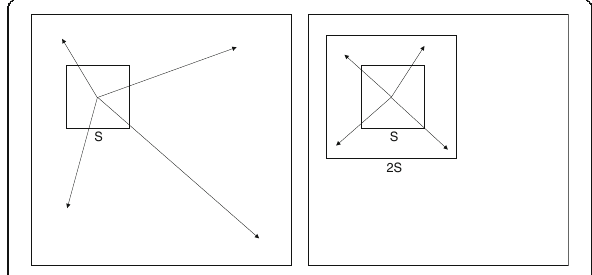
Fig. 3 Reducing search range on superpixels